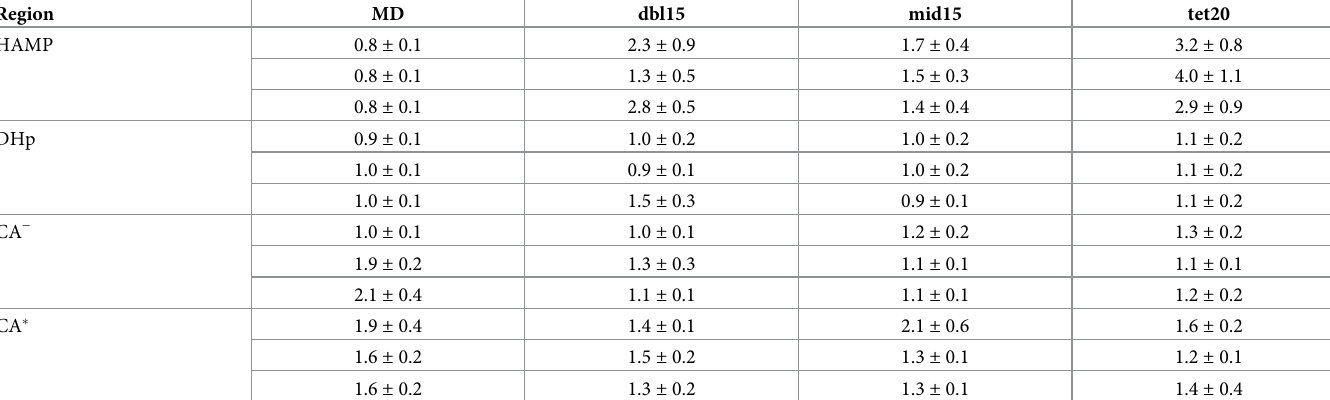
Table 1. Atomic coordinate RMSD ( Å ) averaged along trajectories for different CpxA regions. The RMSD were calculated on heavy atoms of the protein backbone by superimposing each analyzed domain on the corresponding one in the conformation of CpxA in the PDB entry 4BIV. Region MD